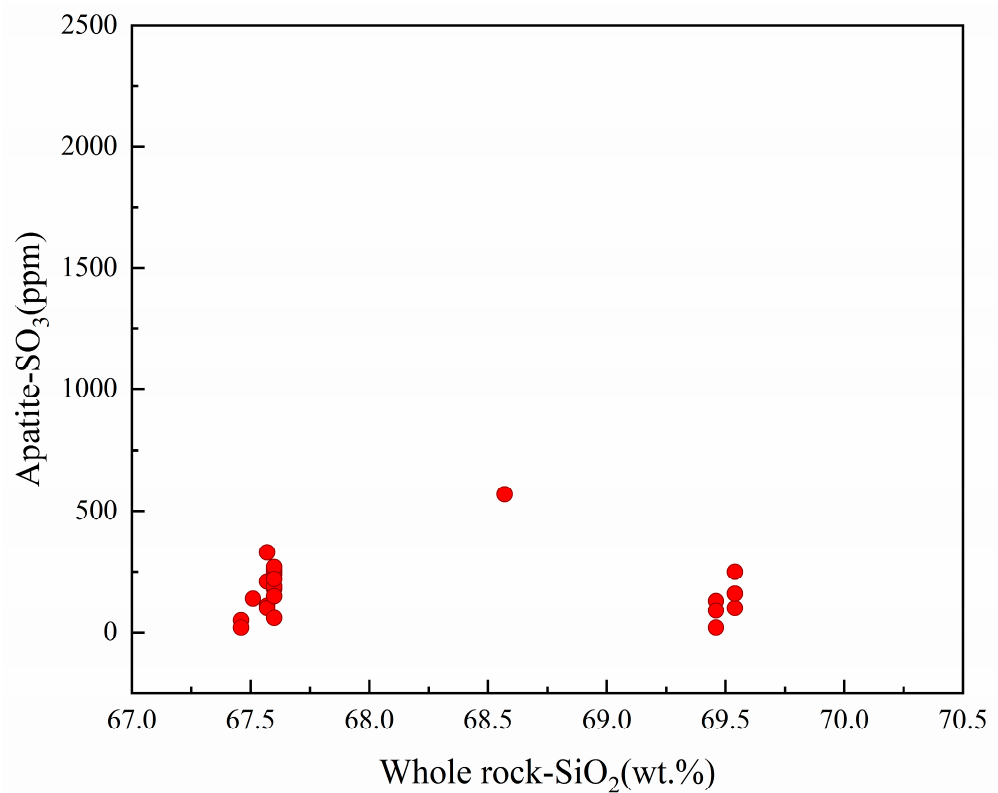
Figure 8. Correlation between SO 3 concentrations in apatites and magmatic